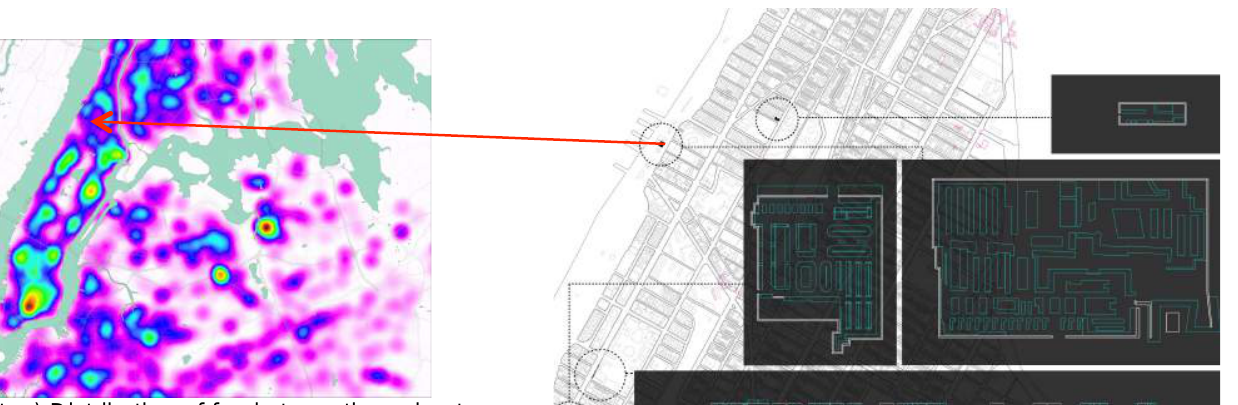
Figure 2. (top) Distribution of food stores throughout New York City, size indicated by diameter (bottom) Proximity to food stores by size as false color rendering. White: no store in 1000 ft. radius. Maps by Cezar Nicolescu